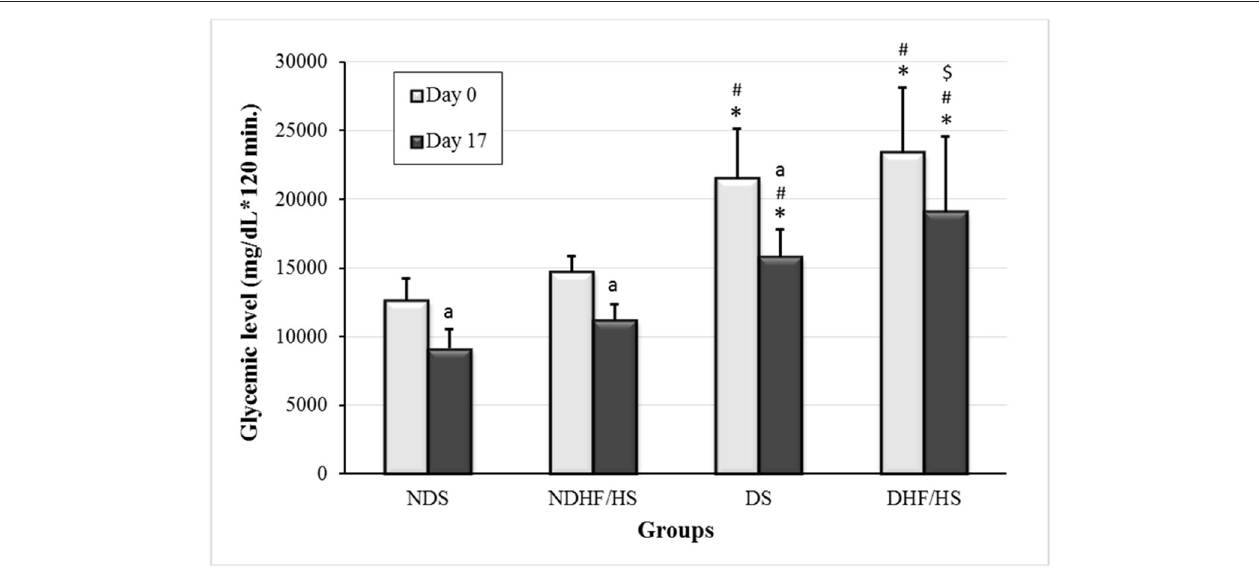
FIGURE 2 | An area under the curve of oral glucose tolerance test (OGTT) on days 0 and 17 of pregnancy of non-diabetic (ND) and diabetic (D) rats treated or not (S), with high-fat/high-sugar diet (HF/HS) before and during pregnancy. Data shown as mean ± standard deviation (SD). * p < 0.05, compared with the NDS group; # p < 0.05, compared with NDHF/HS group; $ p < 0.05, compared with the DS group (ANOVA followed Tukey’s Multiple Comparison test); a p < 0.05, compared with day 0 of pregnancy (Student’s T -test).